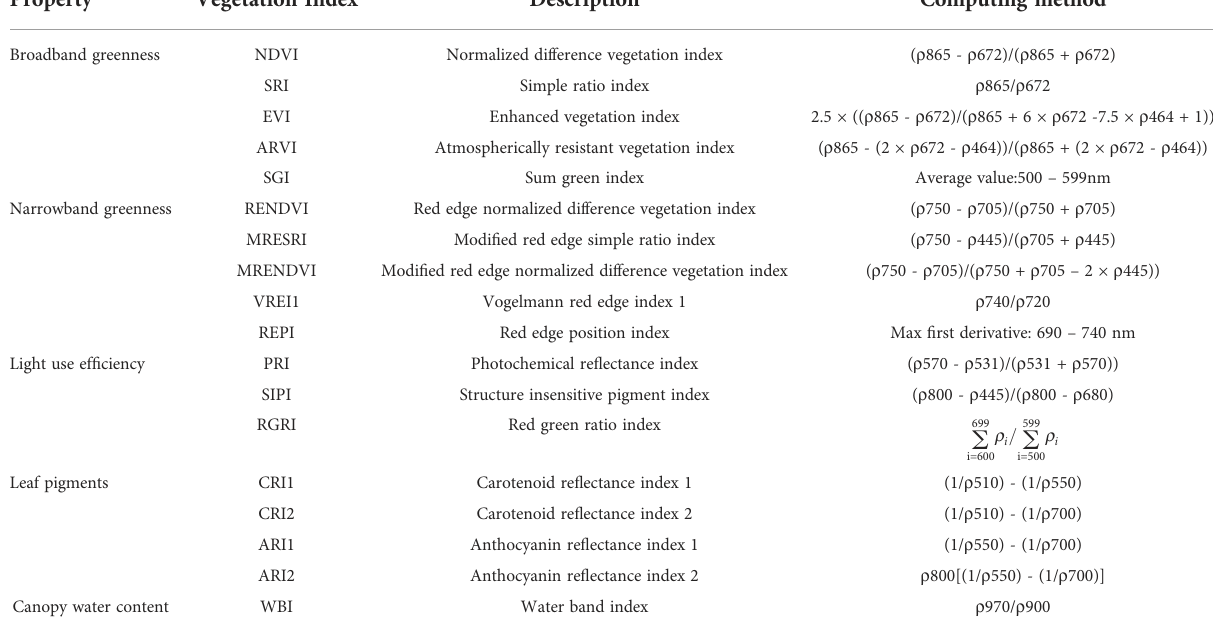
TABLE 1 Calculation table for the vegetation index.